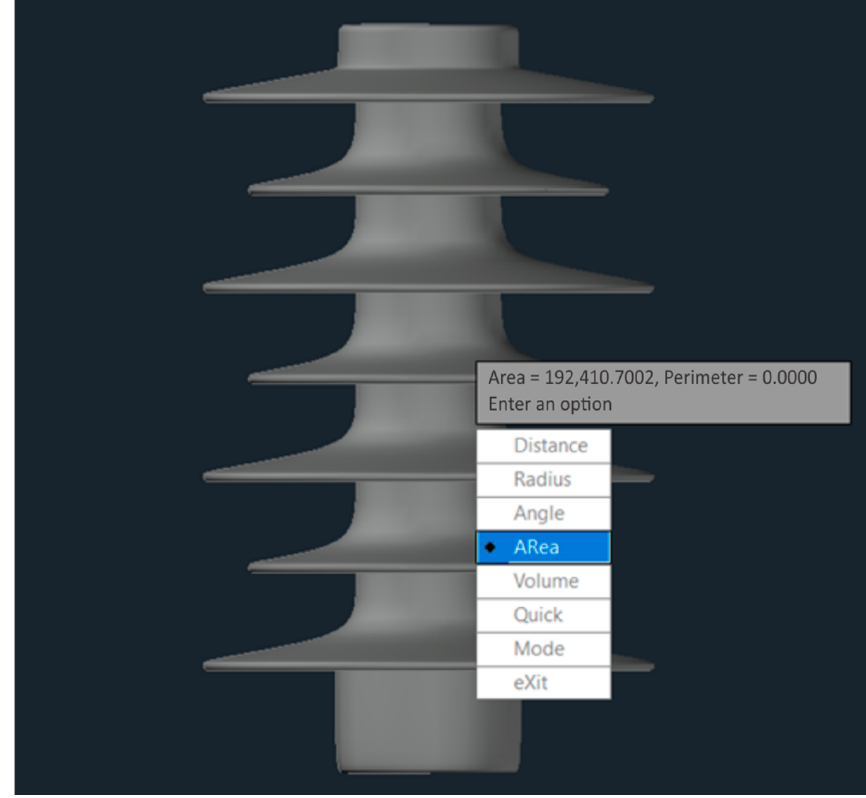
Figure 3. Calculation of insulator area.